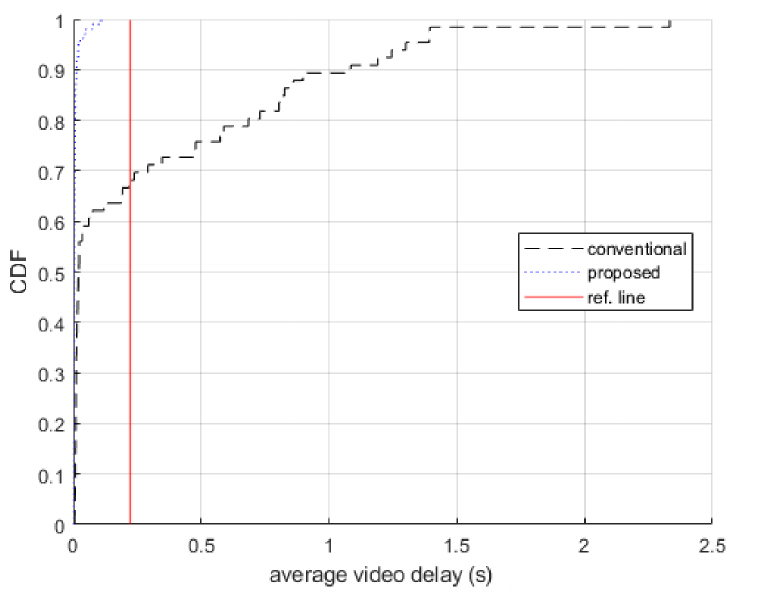
Figure 14. End-to-end delay distribution of video traffic of 100 simulations. ( a ) 802.11e EDCA. ( b ) Situational backoff reset algorithm.